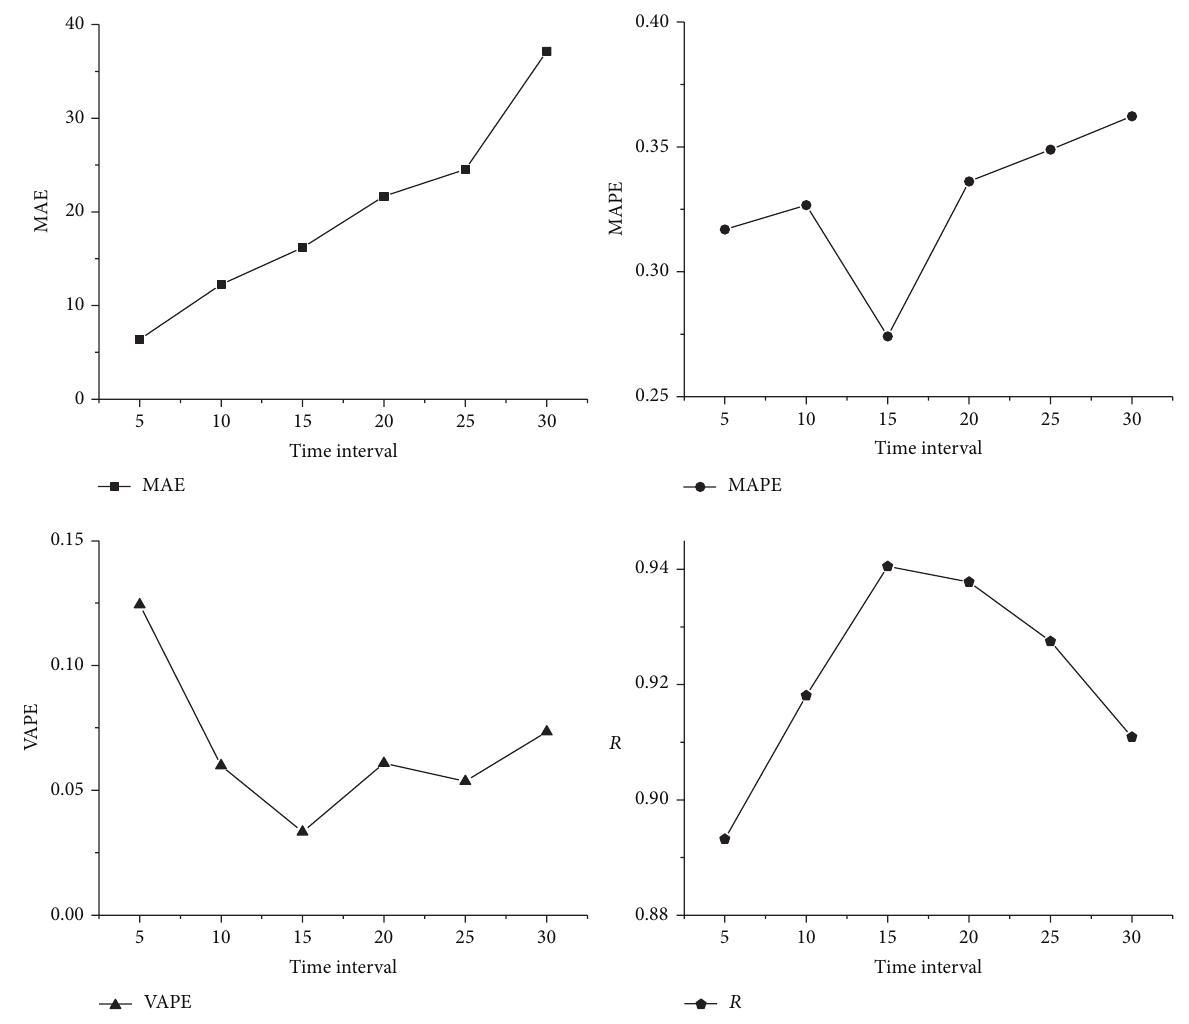
Figure 5: Trends of performance criteria of data set with different time intervals.